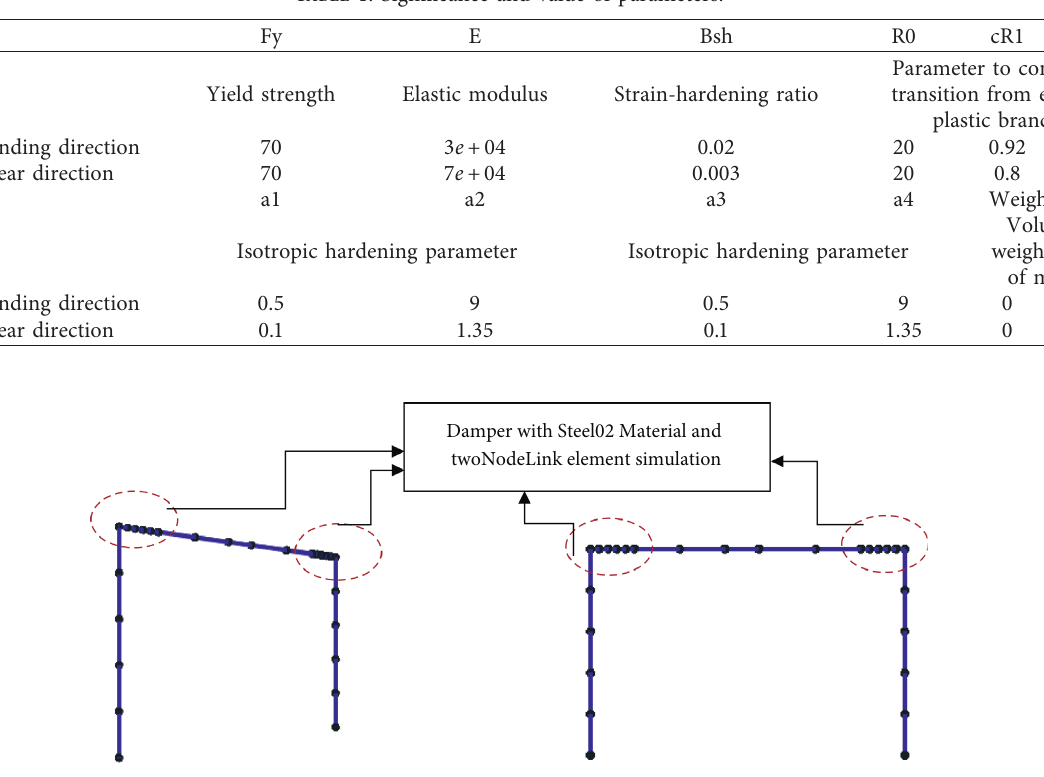
Table 1: Significance and value of